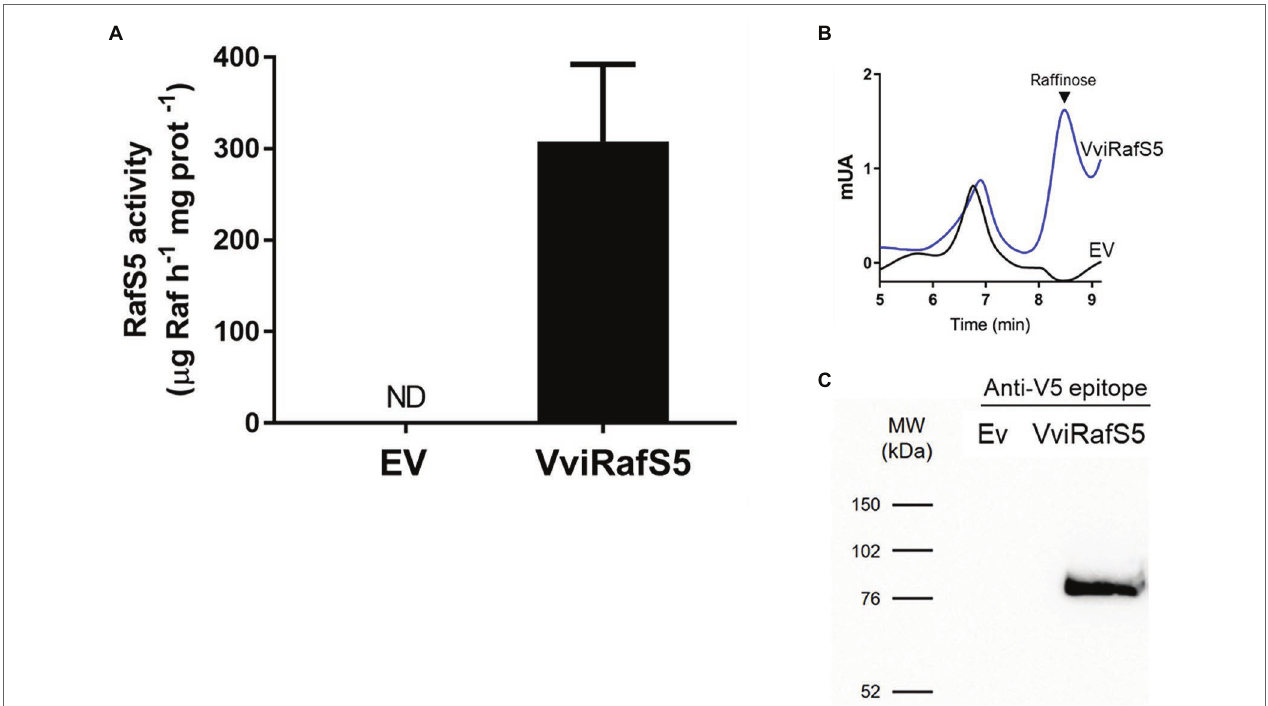
FIGURE 5 | Functional characterization of VviRafS5 . Production of raffinose in protein lysates from INVSc1 yeast expressing VviRafS5 :V5-tag, or the empty vector (EV), when incubated with sucrose and galactinol (A) . Raffinose synthesis was determined by HPLC (B) . Protein production was confirmed trough Western blotting using anti-V5 antibody (C)